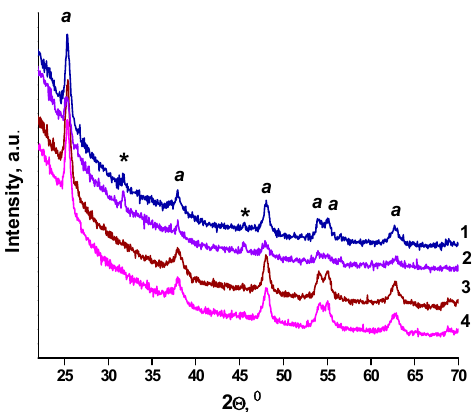
Figure 3. XRD patterns of the films (a-anatase): (1) 1Pt-TiO 2M1 ; (2) 1Pt,N-TiO 2M1 ; (3) 1Pt-TiO 2M2 ; (4) 1Pt,N-TiO 2M2 .